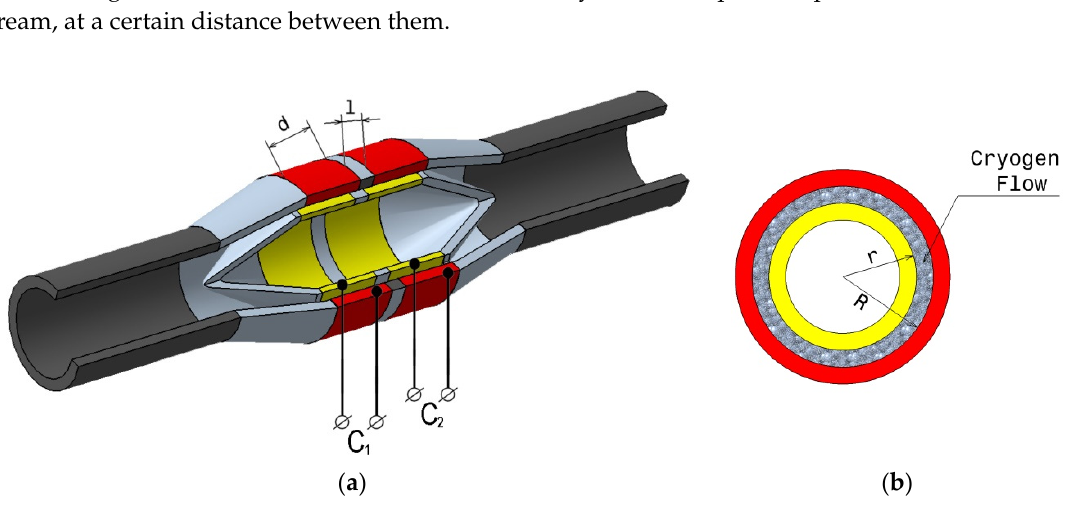
Figure 4. ( a ) Cross section schematic design of the capacitance type flowmeter; ( b ) cross section of one of the capacitor.